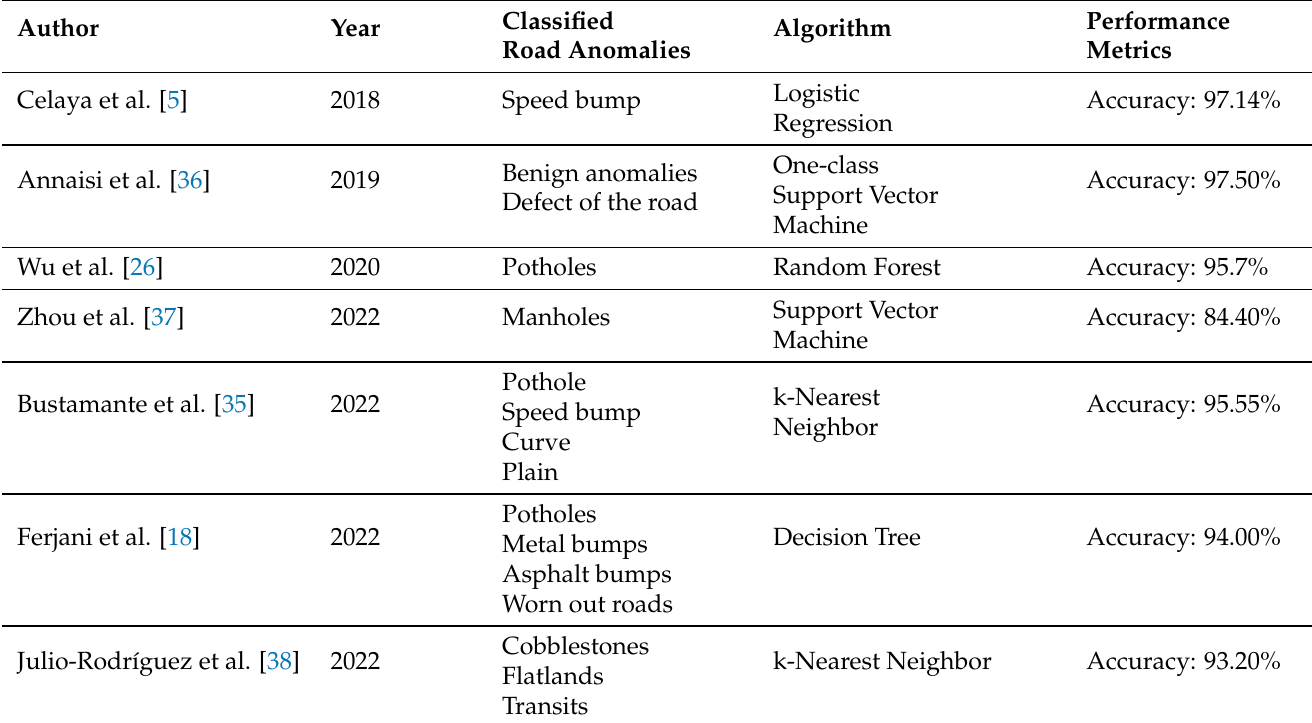
Table 4. Methods used for road anomaly detection and classification based on feature extraction tech-